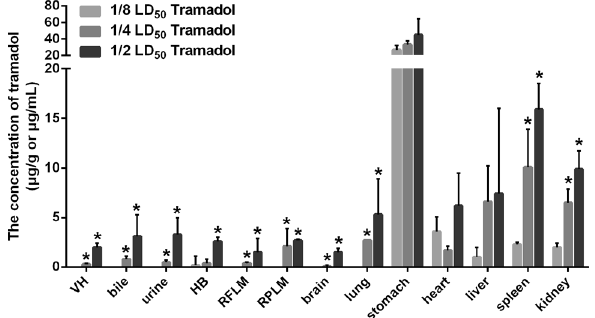
Figure 2. The effect of dosage on postmortem diffusion of tramadol in rabbits. VH vitreous humor, HB heart blood, RFLM right forelimb muscles, RPLM right posterior limb muscles. Data was represented by mean ± standard deviation. * P < 0.05, compared with the concentrations of tramadol in the dosage of 1/8 LD 50